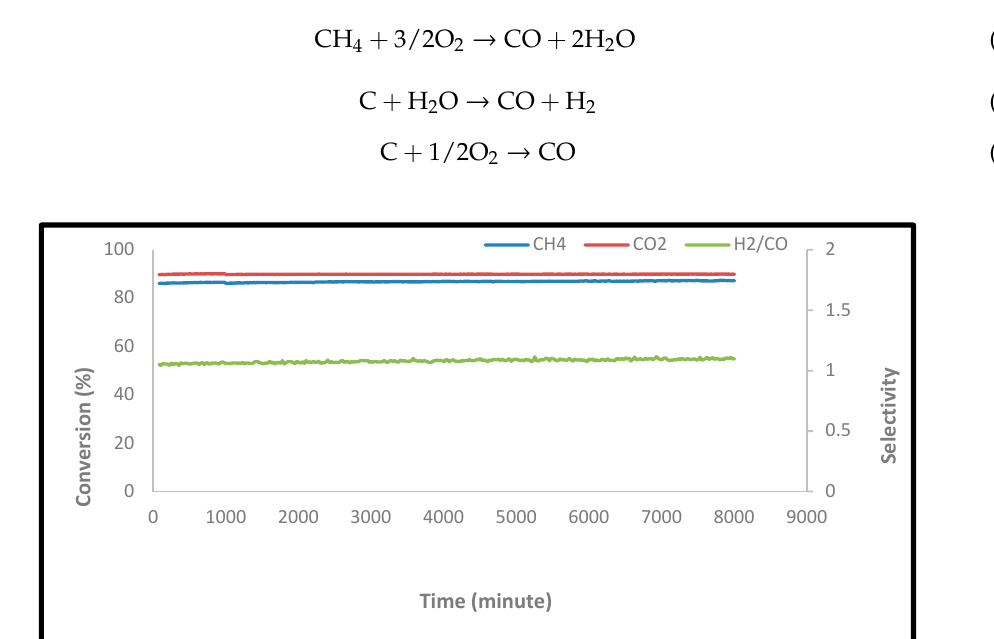
Figure 15. DRM reaction of the Ni,Pd,Pt/Mg 0.85 Ce 4+0.15 O catalyst with a reaction conditions: T = 900 °C, CH 4 /CO 2 ratio of 1:1, 1.25% O 2 , and GHSV = 15,000 mL h − 1 g − 1 cat.